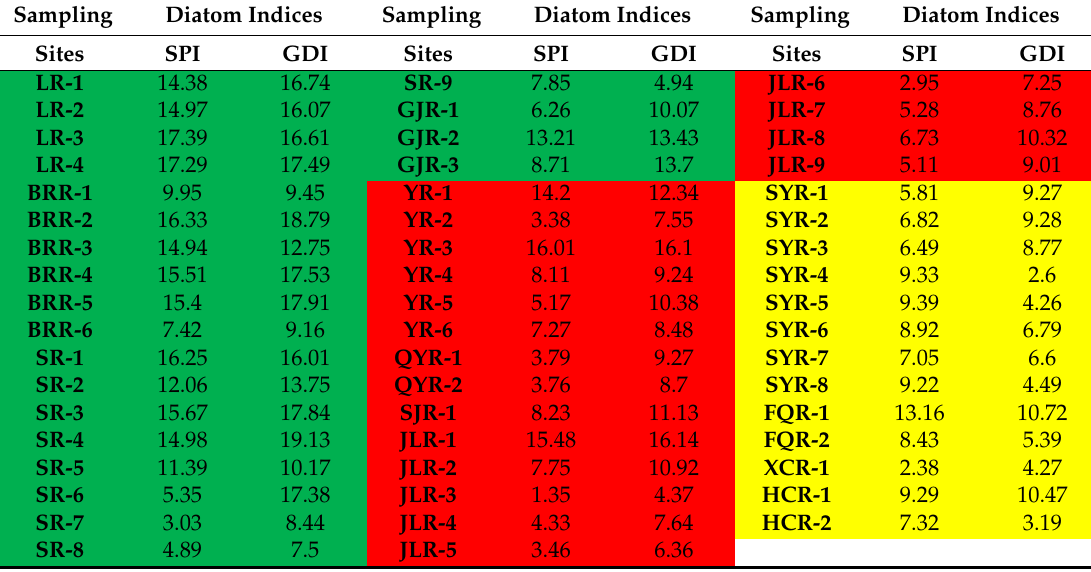
Table 3. Values of diatom indices in each sampling